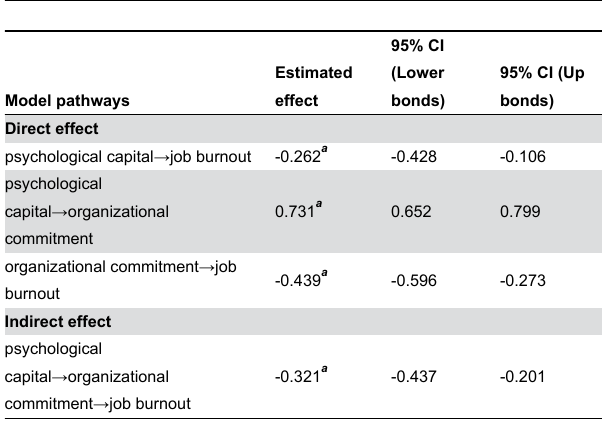
Table 2. Direct and indirect effects and 95 % confidence intervals for the final